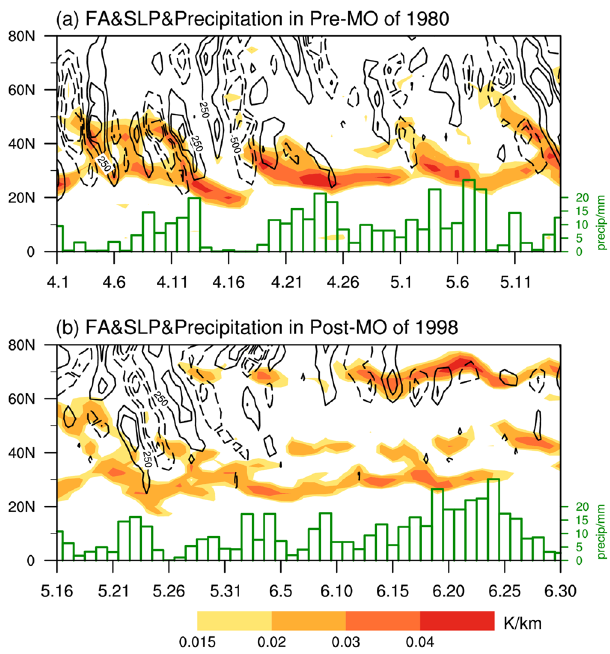
Fig. 3 Inter-connections among mid-latitude synoptic distur- bances, fronts, and SC precipitation. Daily ∂ θ e ∂ and 2 – 8-day fi ltered SLP (contours, Pa) averaged over 105 – 120°E and daily precipitation over SC (green bars, mm) in a the pre-MO period of 1980 and b the post-MO period of 1998. The fronts are indicated by